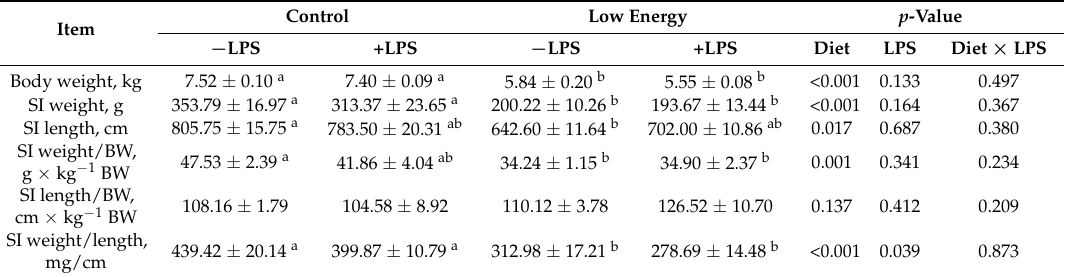
Table 4. Effect of different energy levels during gestation on intestinal index of weaned piglets challenged with Escherichia coli